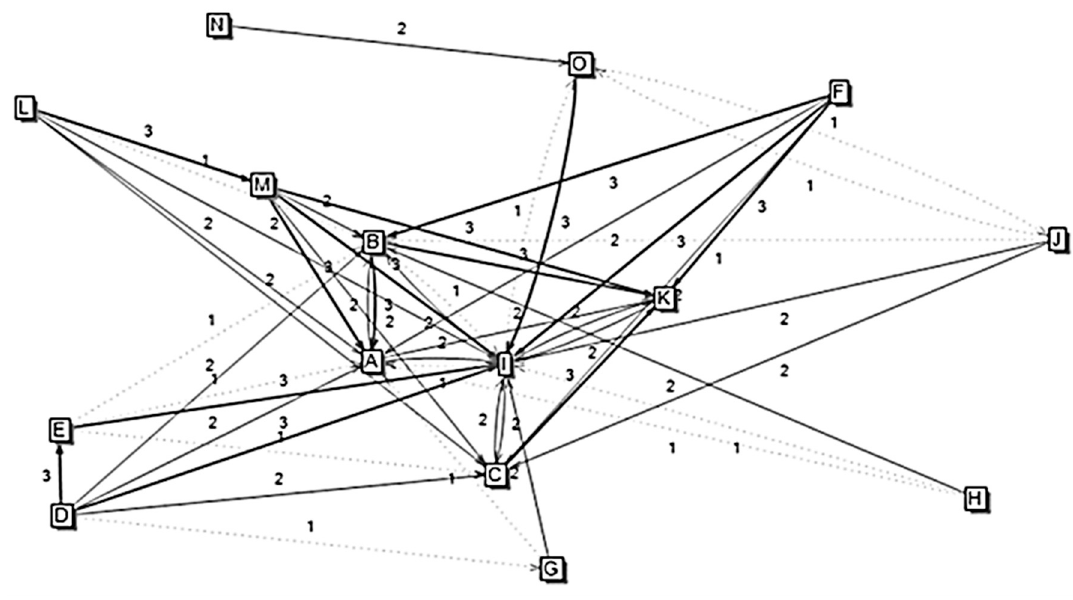
Figure 7. Direct impact graph.